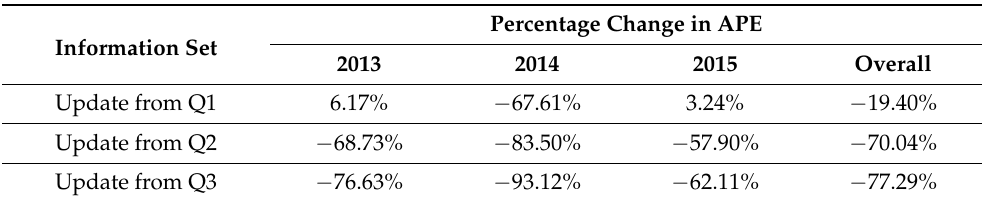
Table 4. Effects of quarterly updates relative to previous year’s annual